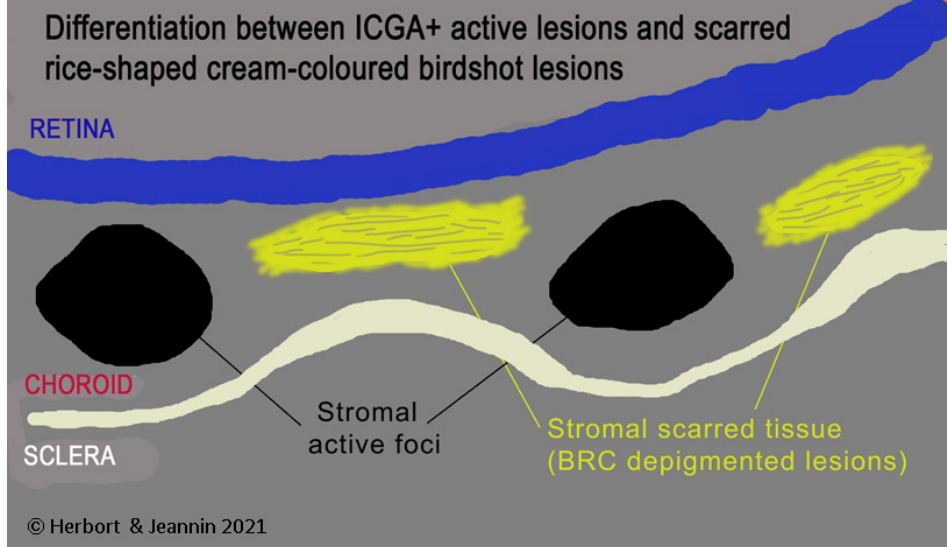
Figure 11. HDDs versus birdshot lesions. Cartoon inspired by Joan Mirò explaining that HDDs seen on ICGA do not correspond to rice shaped cream coloured birdshot lesions which do not appear on ICGA.